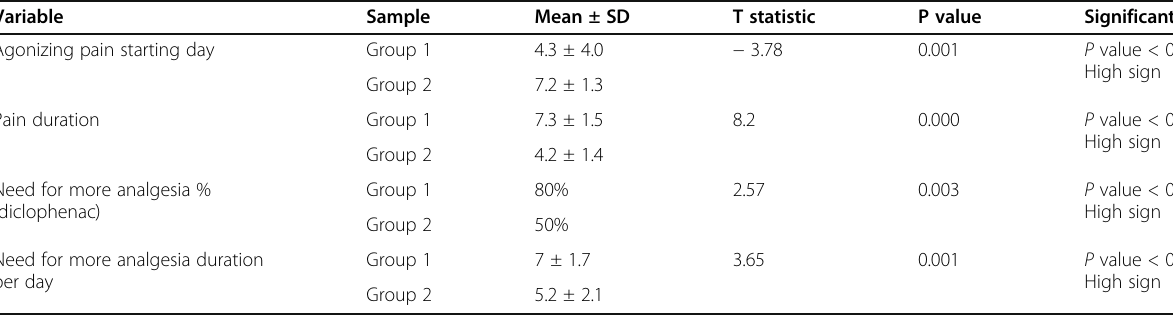
Table 2 The distribution of pain and need for analgesia post-operatively